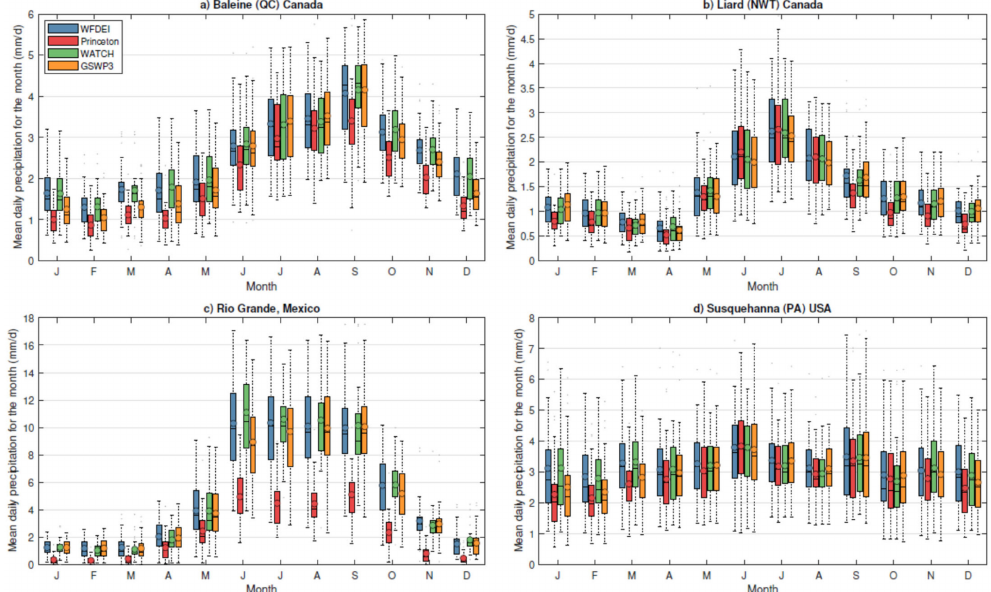
Figure 6. Mean daily precipitation for each month from the four global meteorological datasets (WFDEI, Princeton PGMFD, WATCH, and GSWP3) over the ( a ) Baleine, ( b ) Liard, ( c ) Rio Grande, and ( d ) Susquehanna river basins during the 1971–2010 period.